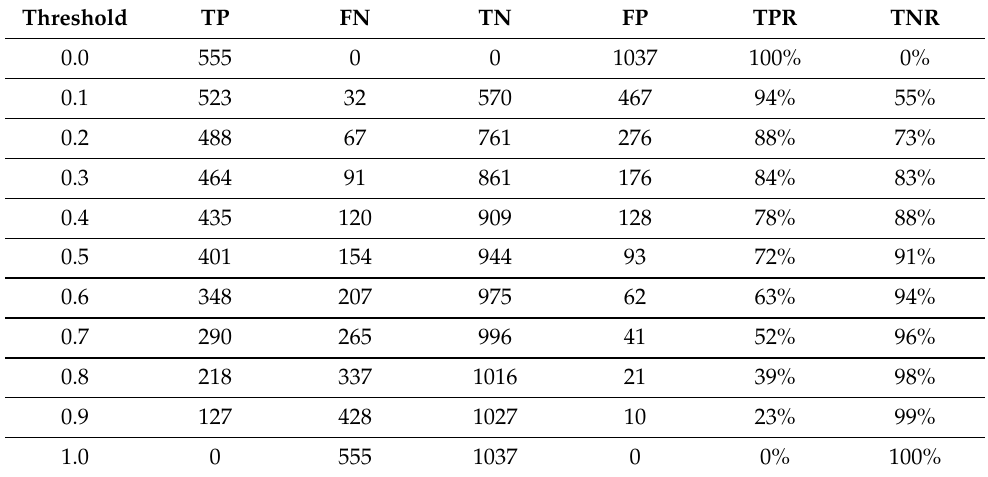
Figure 10. The ROC curve of 1592 testing samples. Table 10. Performance with varying threshold value on classification of 1592